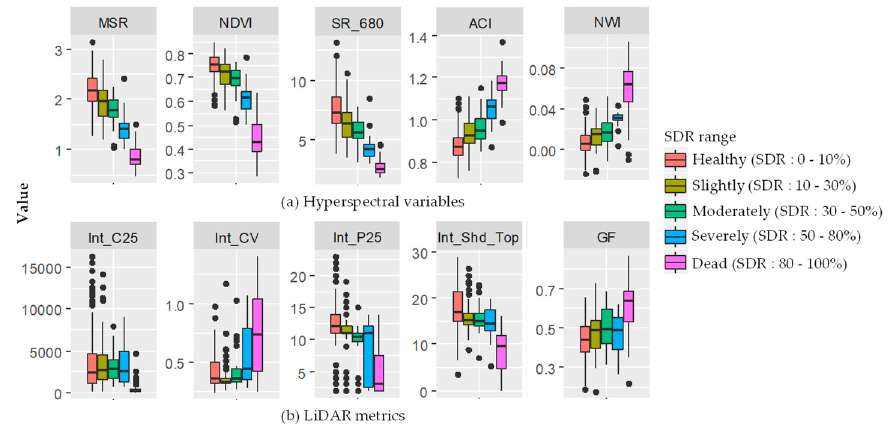
Figure 7. Comparison of different SDR ranges of ten variables derived from hyperspectral variables and lidar metrics.